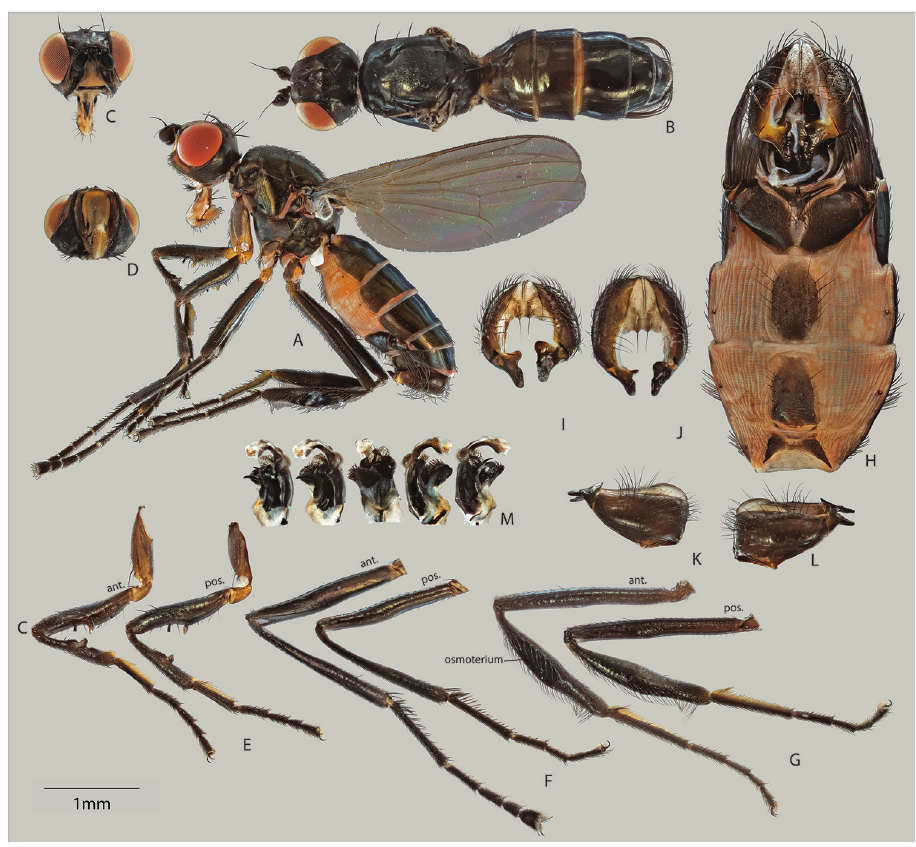
Figure 2. Adult male ( A–M ), showing lateral ( A ) and dorsal ( B ) views of habitus, anterior ( C ) and ven- tral ( D ) views of head capsule, anterior and posterior views of fore leg ( E ), mid leg ( F ) and rear leg ( G ); ventral view of abdomen ( H ) showing modified 4 th sternites; anterior ( I ), dorsal ( J ), left ( K ) and right ( L ) views of hypopygium, as well as various views of the penis ( M